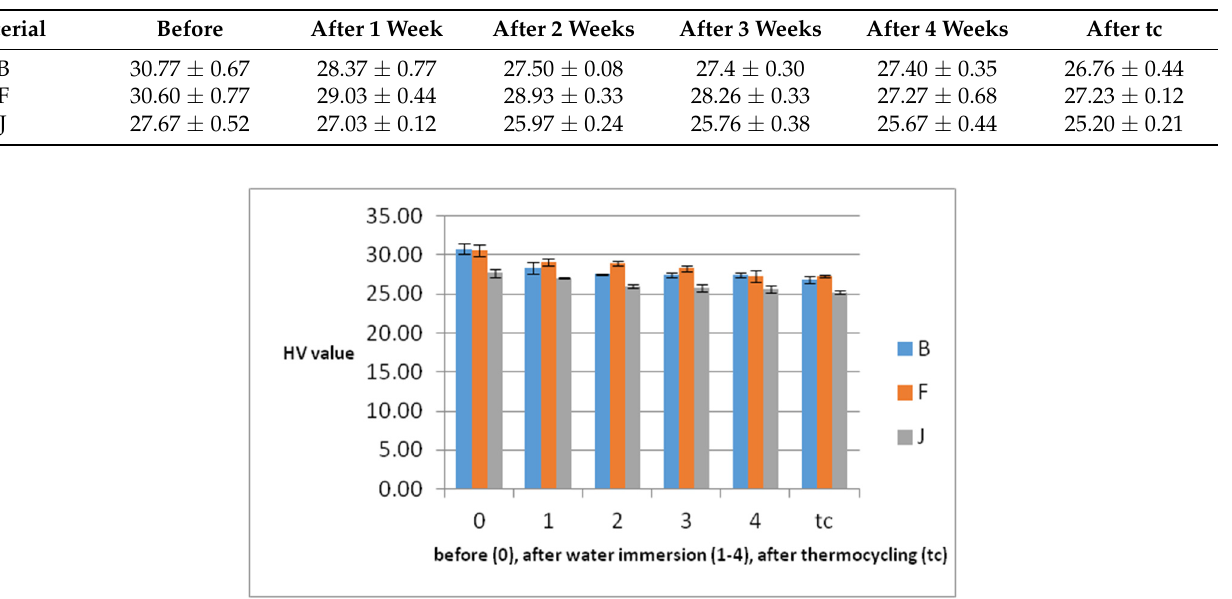
Figure 6. Mean hardness values of the samples with SD before each week of water immersion (0), after (1–4), and after thermocycling.